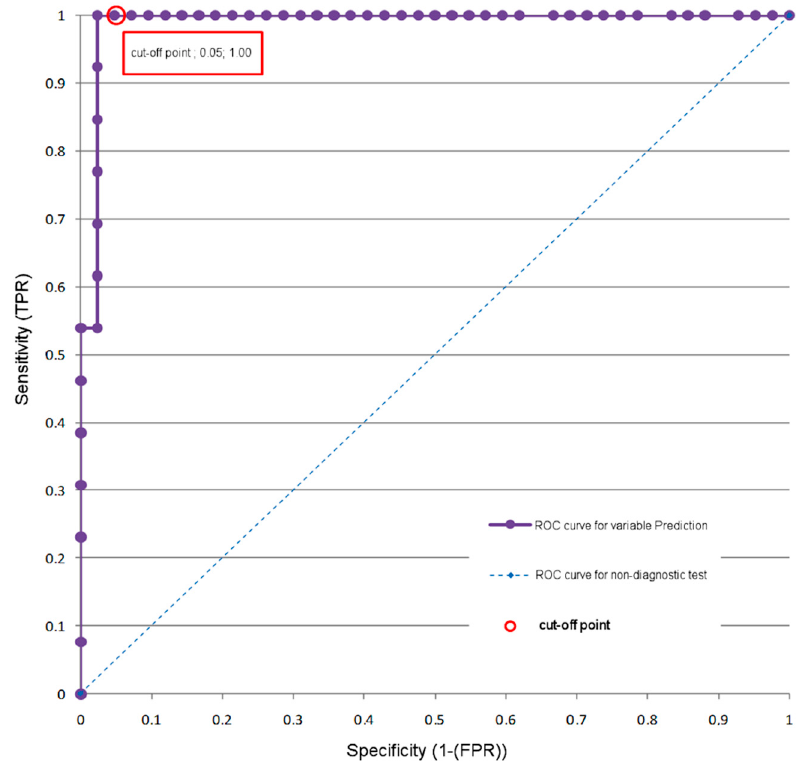
Figure 2. ROC analysis—a model using the magnetic resonance brain perfusion with acetazolamide and magnetic resonance angiography of the intracranial arteries. ROC curve for the prediction variable (by cross-clamping test results).